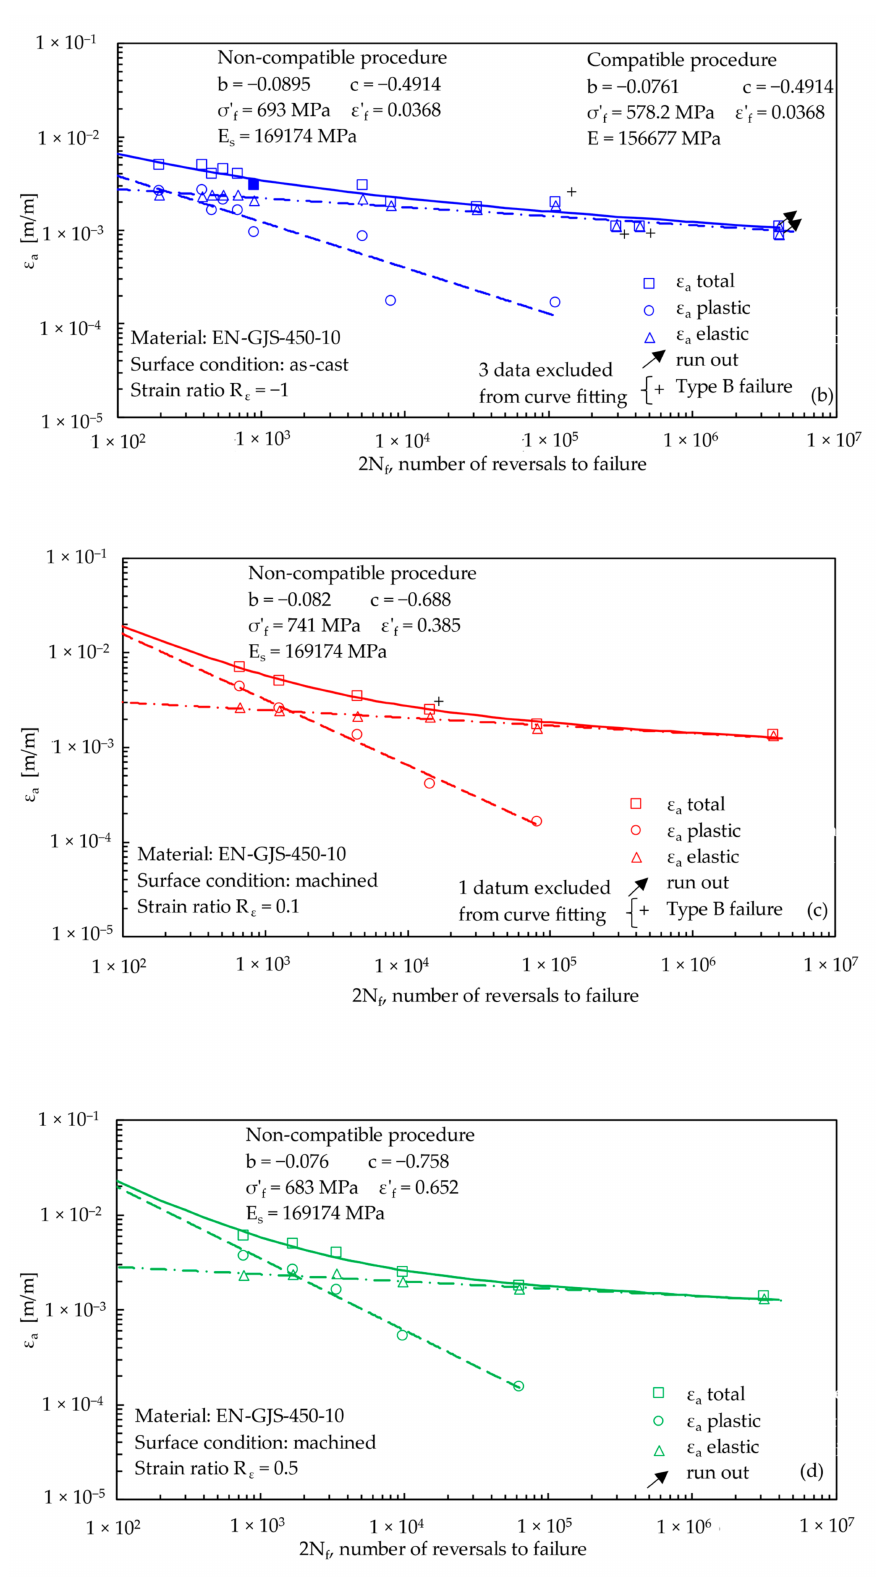
Figure 10. Manson–Coffin curves of EN-GJS-450-10 tested under R ε = − 1 in the ( a ) machined and ( b ) as-cast conditions; ( c ) R ε = 0.1 and ( d ) R ε = 0.5 in the machined conditions. The figures include the curves fitted by the non-compatible procedure and the parameters to input in Equation (3) according to both the non-compatible and the compatible